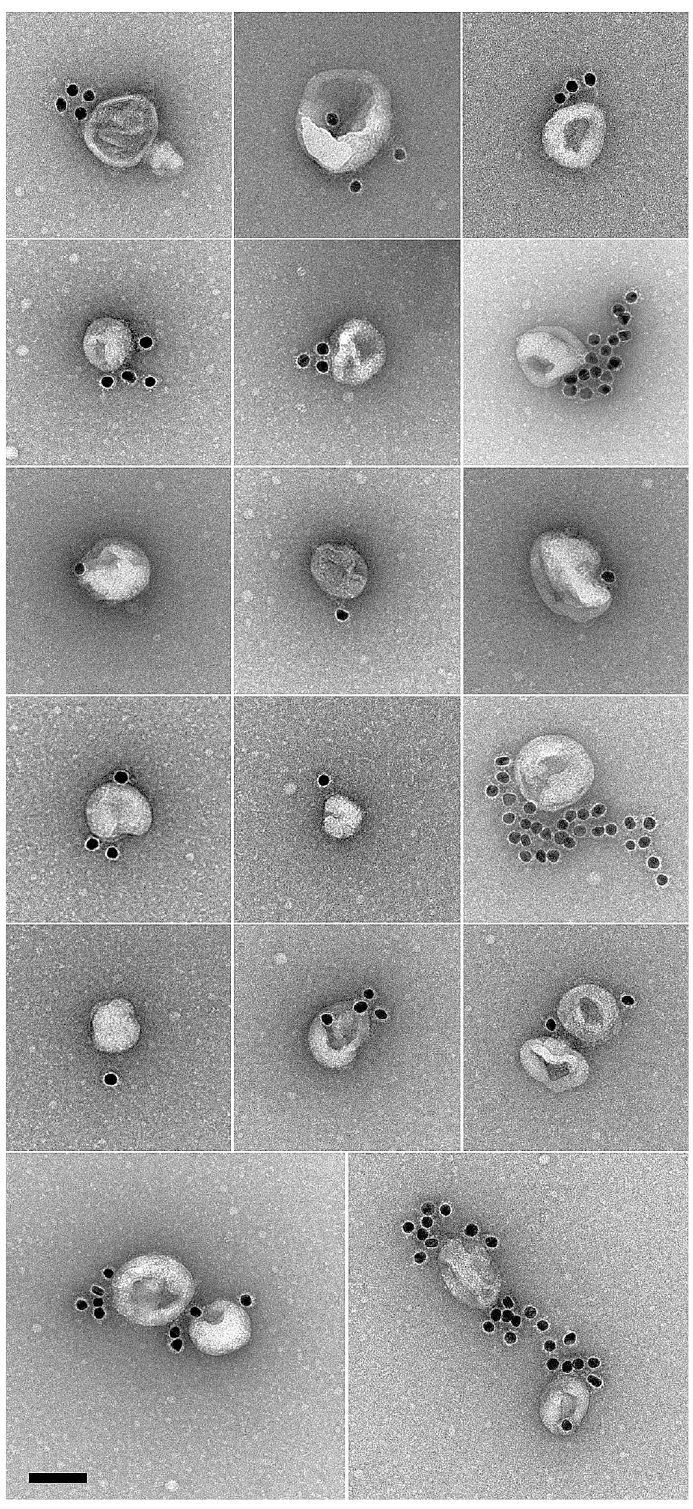
Figure 2. Negative stain electron microscopy reveals SARS-CoV-2 VLPs specifically labeled with immunogold. Scale bar : 100